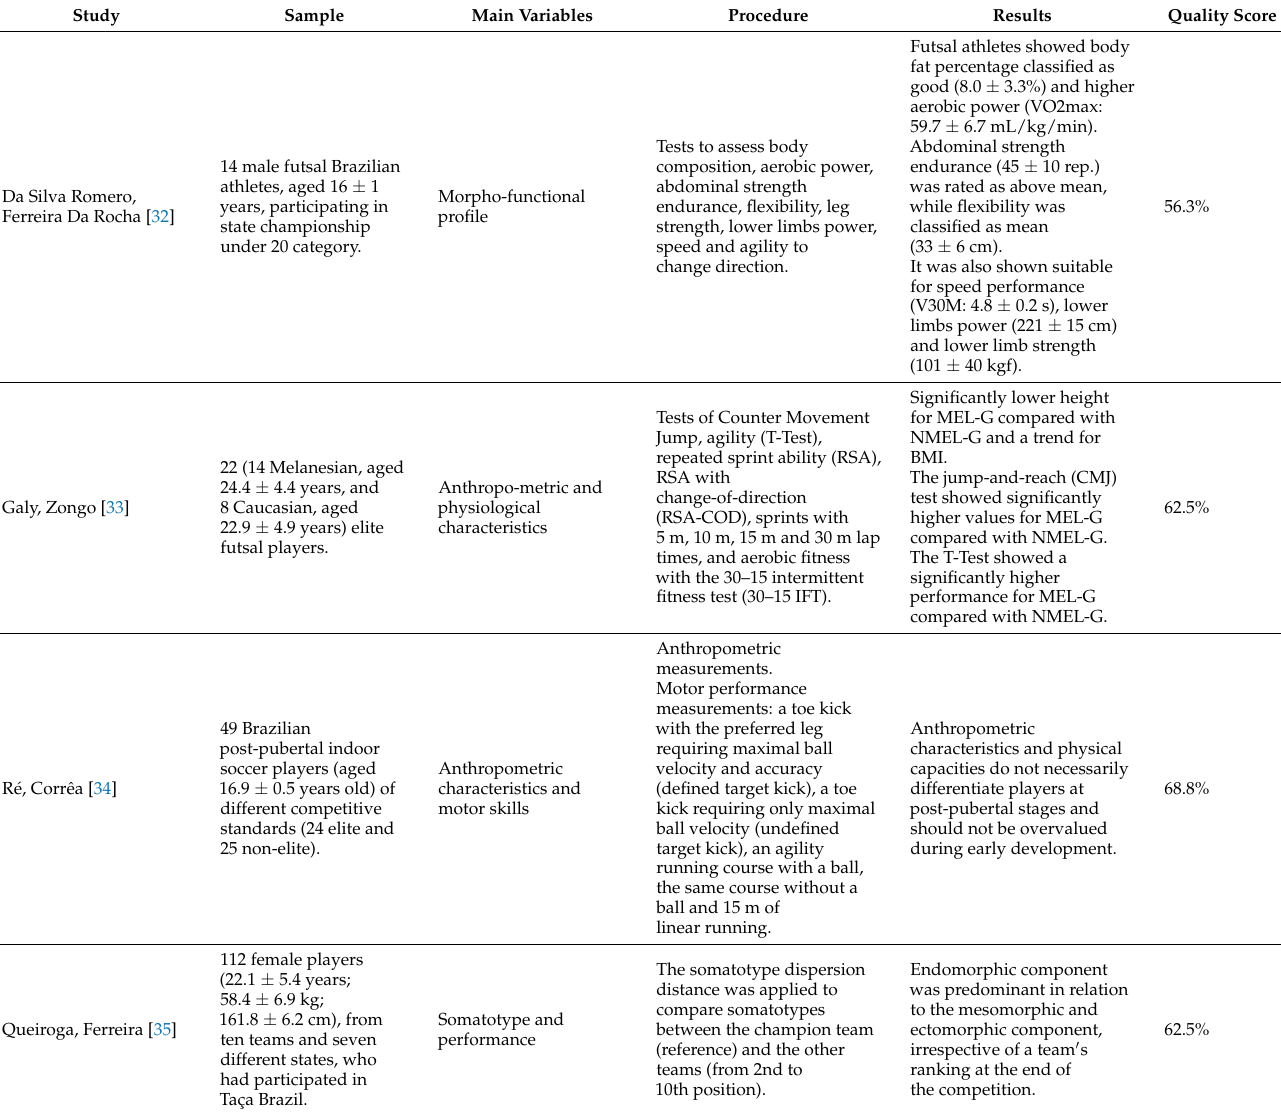
Table 6. Studies with predominantly anthropometric and physiological